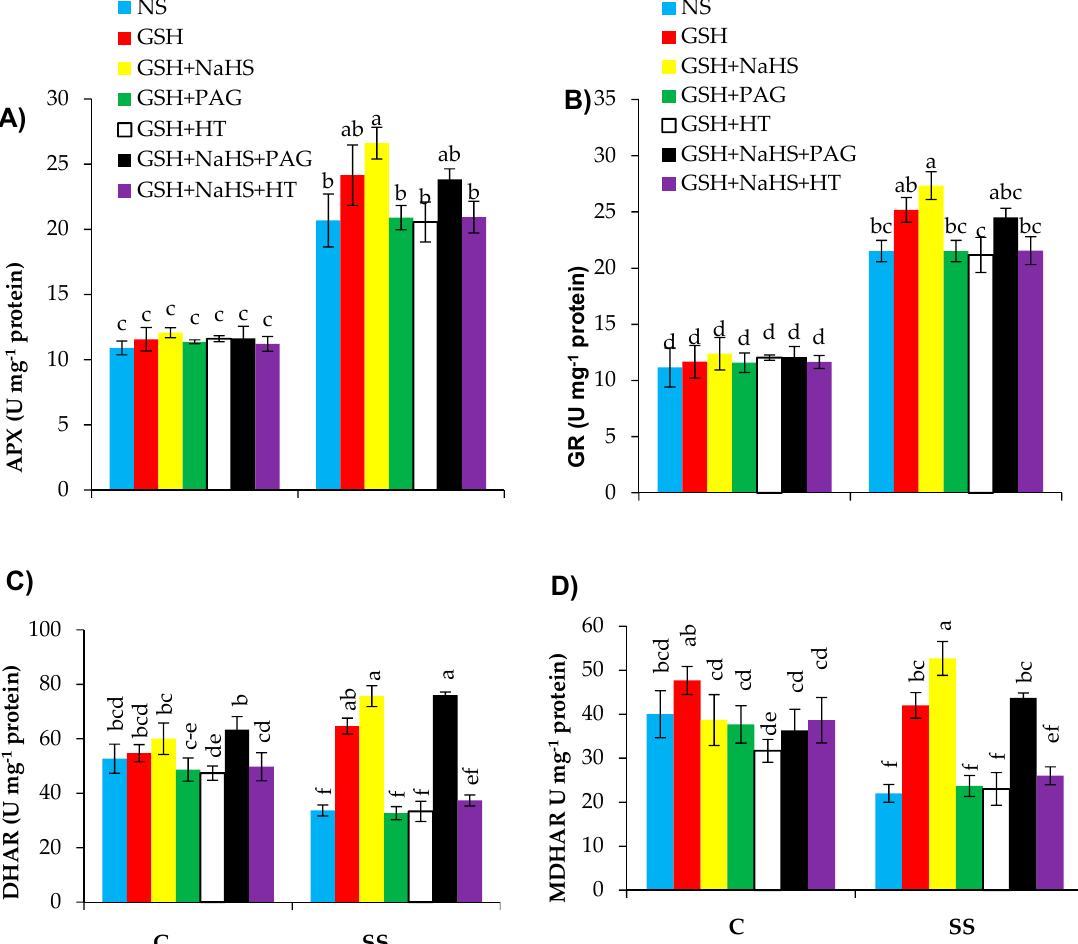
Figure 8. Activities of ascorbate peroxidase (APX ( A )), glutathione reductase (GR ( B )), dehydroascorbate reductase (DHAR ( C )), and monodehydroascorbate reductase (MDHAR ( D )) in pepper plants grown under control (C) and salinity stress (SS 100 mmol L − 1 NaCl), sprayed with glutathione (1.0 mmol L − 1 GSH) or sodium hydrosulfide (0.2 mmol L − 1 NaHS) alone or together, combined with a 0.1 mmol L − 1 scavenger of H 2 S, hypotaurine (0.1 mmol L − 1 HT), or inhibitor of L -DES, DL -propargylglycine (0.3 mmol L − 1 PAG). (Mean ± SE). Mean values carrying different letters within each parameter differ significantly ( p ≤ 0.001) based on Duncan’s multiple range test.